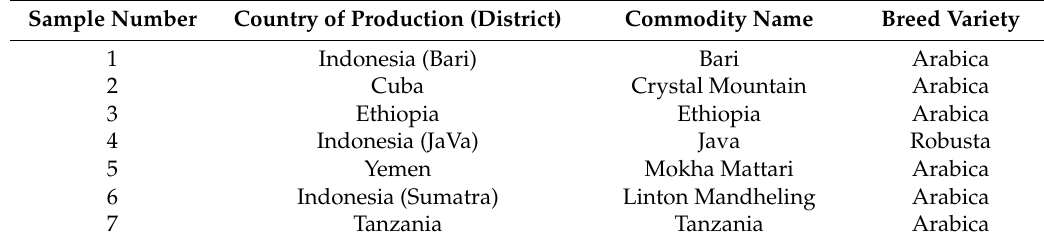
Table 1. Coffee sample information for